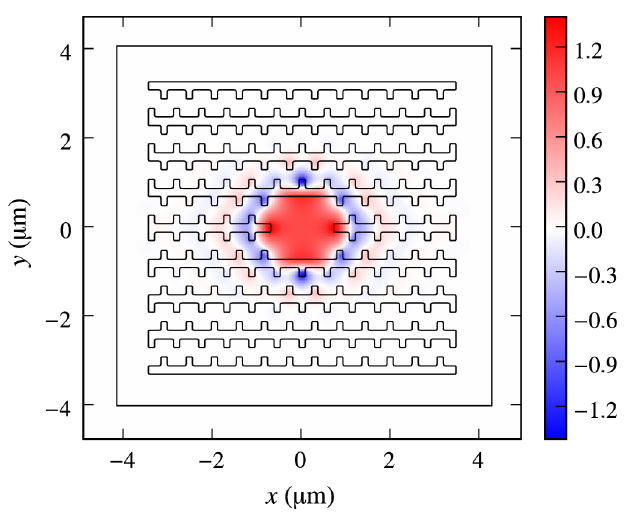
FIG. 4. The accelerating field seen by a speed-of-light particle, averaged over a lattice period, normalized to the accelerating field on axis, shown with structure contours for a transverse slice at z (cid:3) 0 . The inner rectangle denotes the interface between free space and the absorbing boundary in the